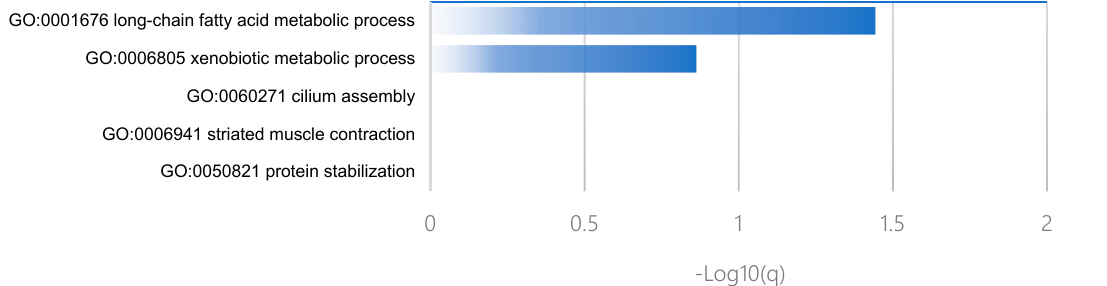
Figure 5. Protein–protein interaction enrichment analysis showing physical interactions formed among the upregulated (blue) and downregulated (yellow) proteins in Hacl1 − / − liver.